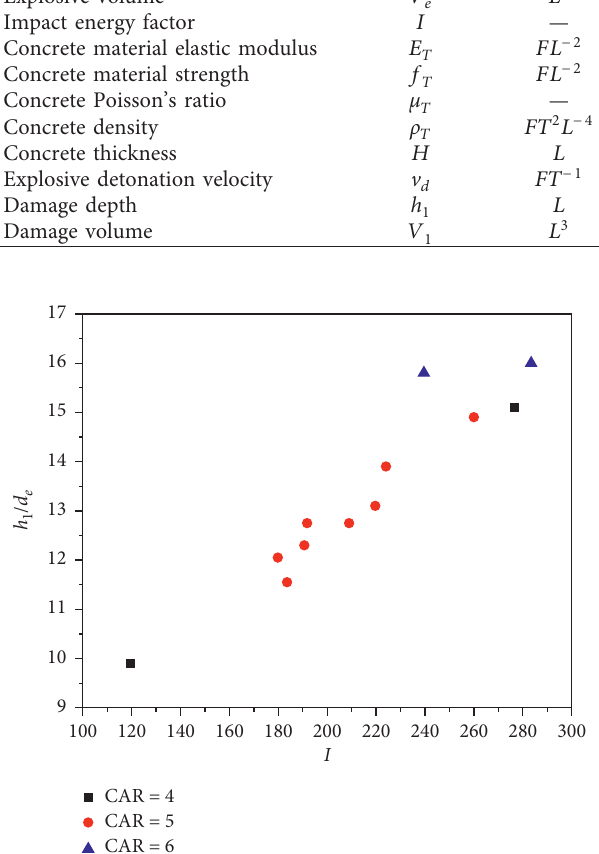
Figure 12: Experimental data at the dimensional damage